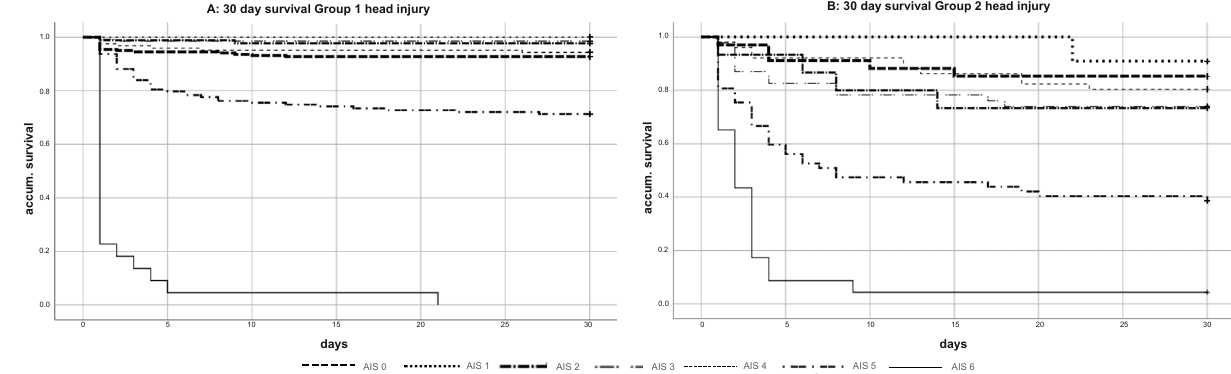
Figure 5. ( A , B ) Kaplan–Meier curves of 30-day survival in dependence of the head severity (with AIS 0 = no head injury and AIS 6 = maximum head injury). The relative risk (odds ratio) to die of head injuries was 45% higher in the older population (7.132 vs. 4.905, Table 2) compared to the younger patients. Table 2. Odds ratios of ISS injury regions in both age groups.